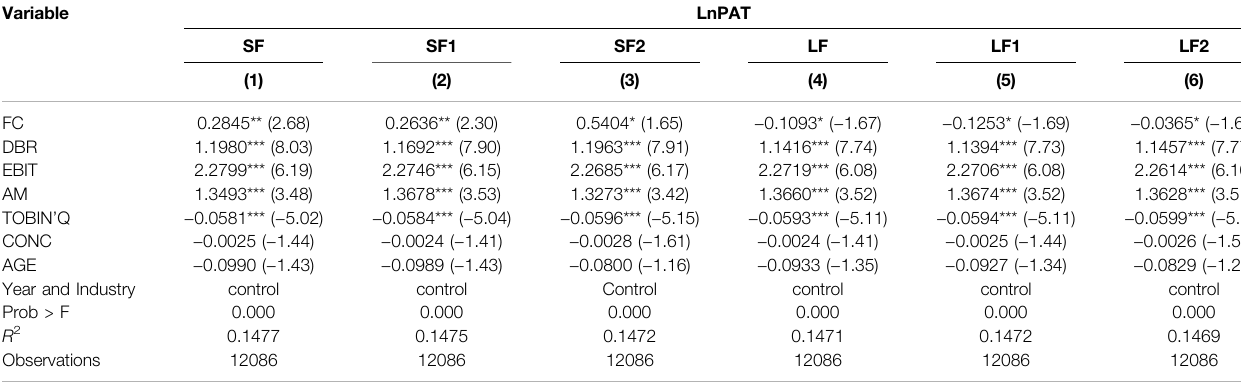
TABLE 7 | Regression results of fi nancialization on the patents for fi rm innovation. Variable